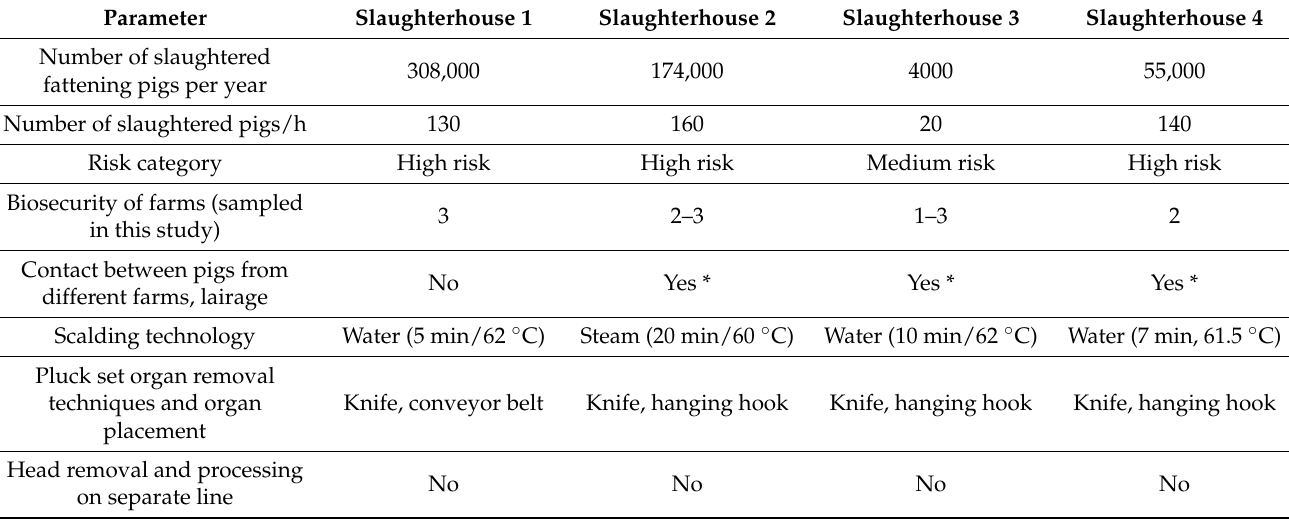
Table 1. Characteristics of slaughterhouses included in this